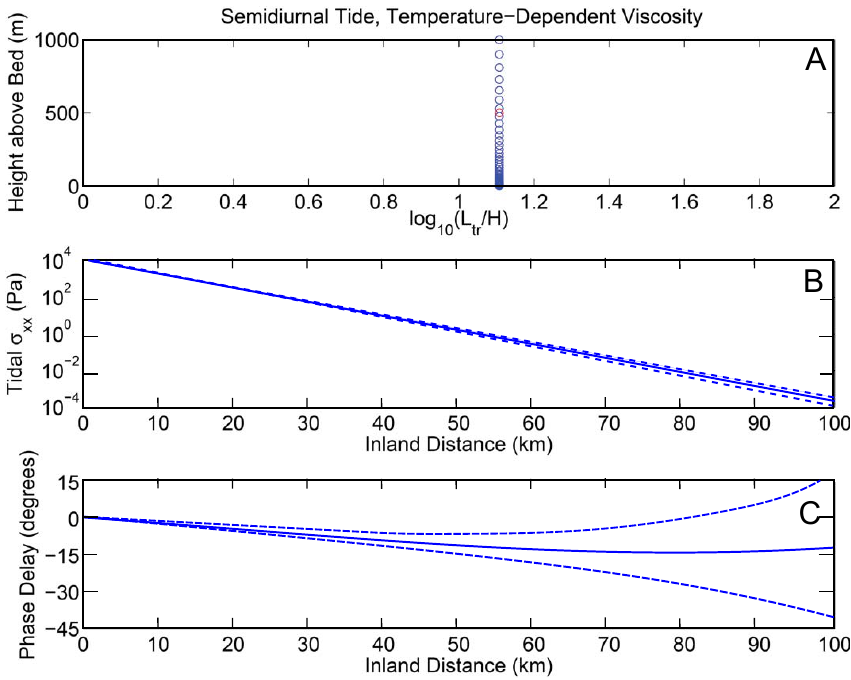
Figure 10. Model results for a temperature-dependent viscoelastic model forced by a semidiurnal tide. (a) shows the calculated values of L tr for depth profiles of the stress with result in an average value of L tr of 12.81 ± 0.001km. (b) shows the value of the longitudinal normal stress ( σ yy ) as a function of horizontal coordinate. (c) shows the fitted phase shift ϕ as a function of horizontal coordinate. In (b) and (c) , the dashed lines correspond to the 95% confidence interval values of the fit.